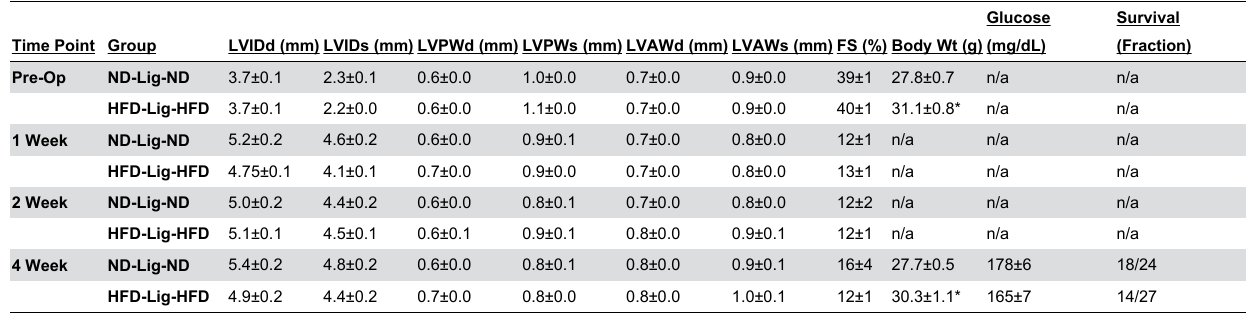
Table 2. Left ventricular diameters, wall thicknesses, and fractional shortening of the pre-fed HFD group; additionally, body weight, blood glucose, and survival